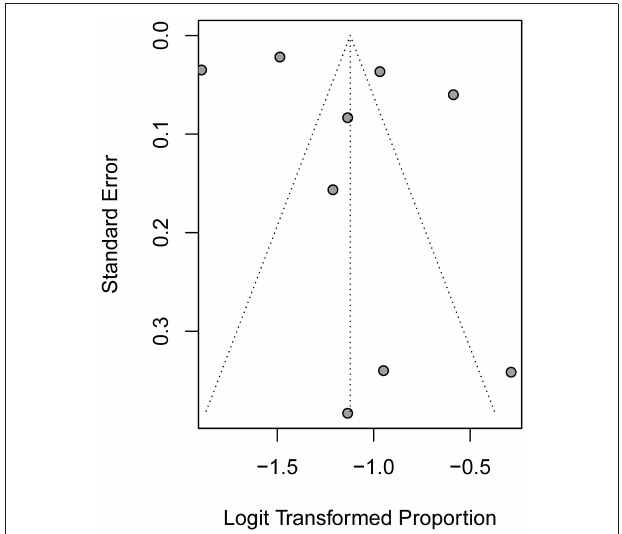
FIGURE 3 | Funnel plot of publication bias among the nine included studies.